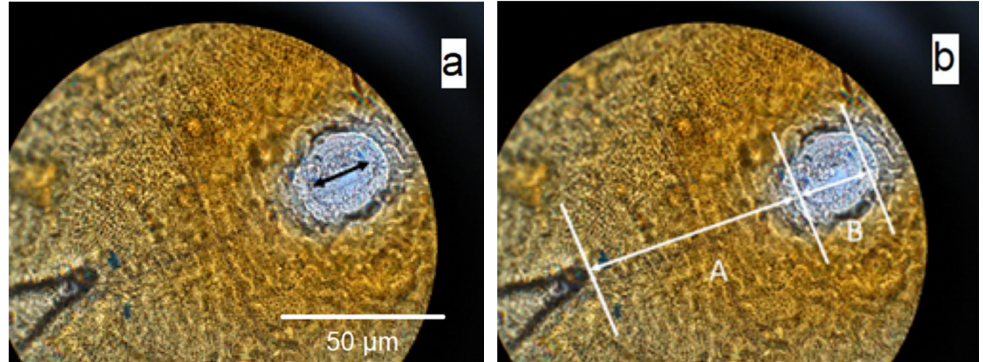
Figure 8. ( a ) Image of perineal region of Globodera , showing the “halo” effect around the vulval basin, the actual diameter of which is marked by an arrow. ( b ) Measurements taken to calculate Granek’s ratio, where A is the distance from the anus (at the apex of the V-shaped cuticular mark) to the vulval basin, and B is the diameter of the vulval